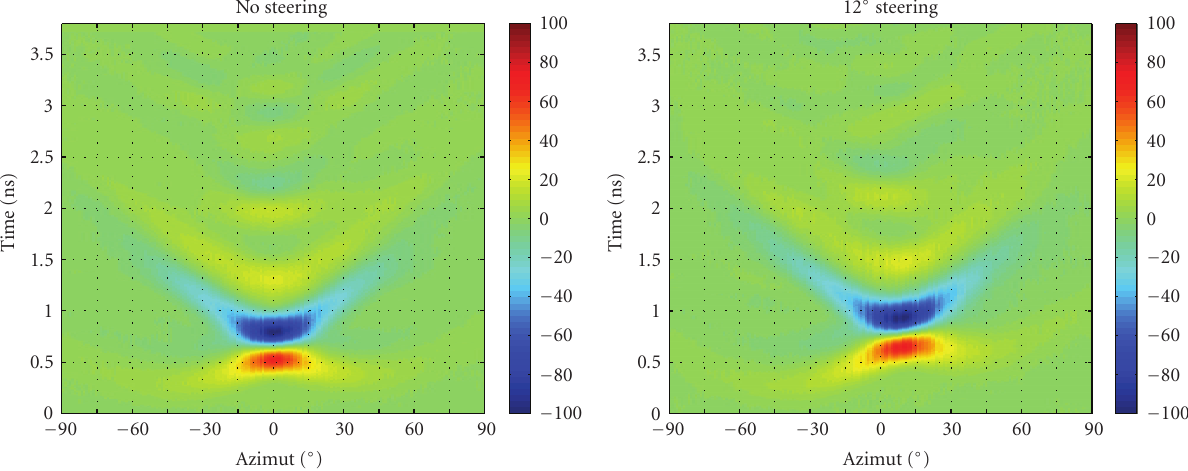
Figure 6: Transient radiation patterns in the H-plane.